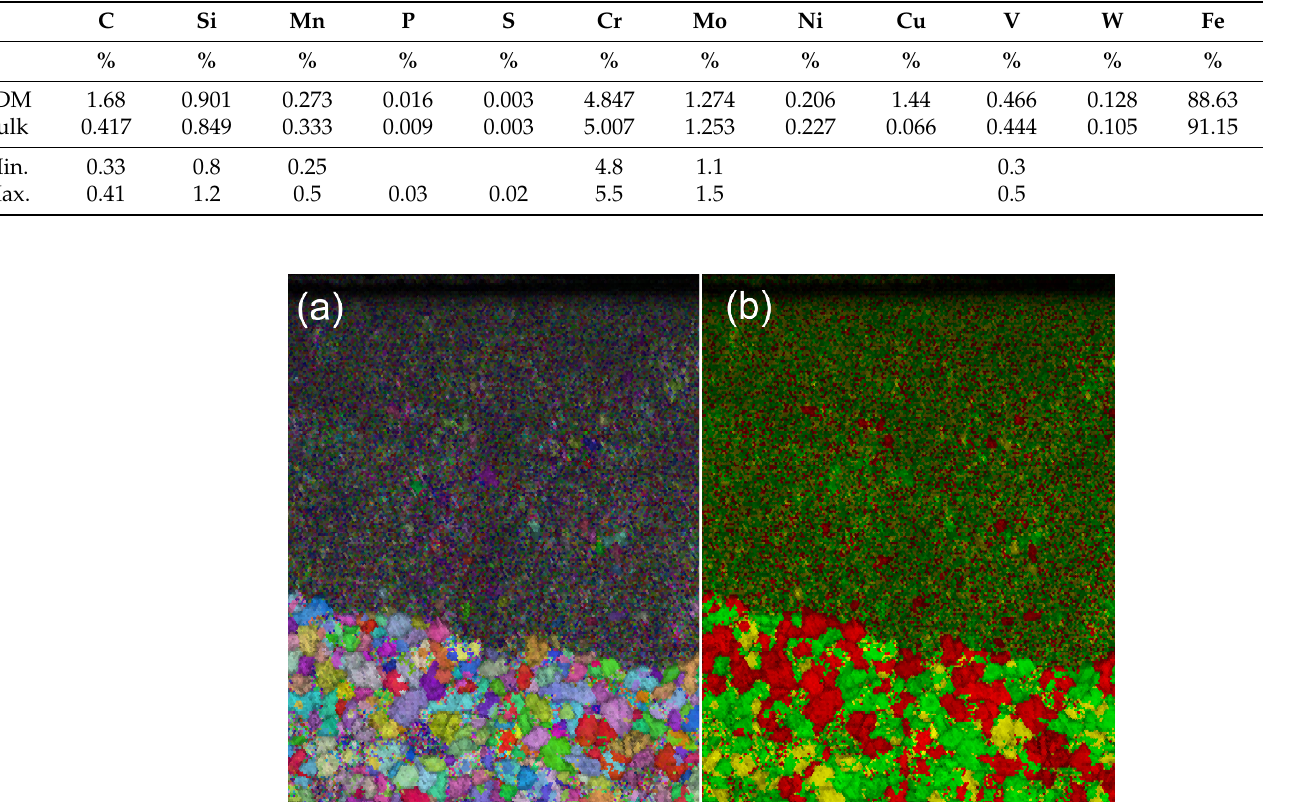
Table 8. Chemical composition measured on the EDM surface and on for the bulk, below is the target values defines for X38CrMoV5-1 steel.